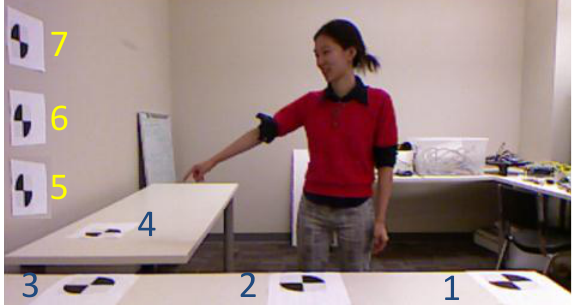
Figure 8: Our study involved six users that pointed to seven targets being recorded using 30 frames per target. Four targets were placed horizontally on the table (indicated in blue) and three targets were place vertically on the wall (indicated in yellow).